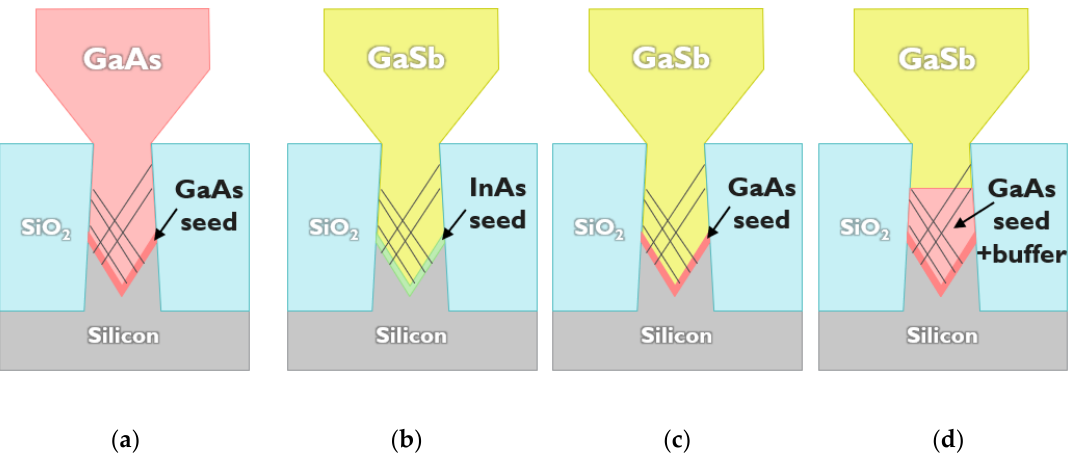
Figure 1. Layer sketch of the investigated GaAs and GaSb nano-ridges (NRs) showing the seed and buffer materials: ( a ) GaAs NR on GaAs seed, ( b ) GaSb NR on InAs seed, ( c ) GaSb NR on GaAs seed, ( d ) GaSb NR on GaAs seed and GaAs buffer.